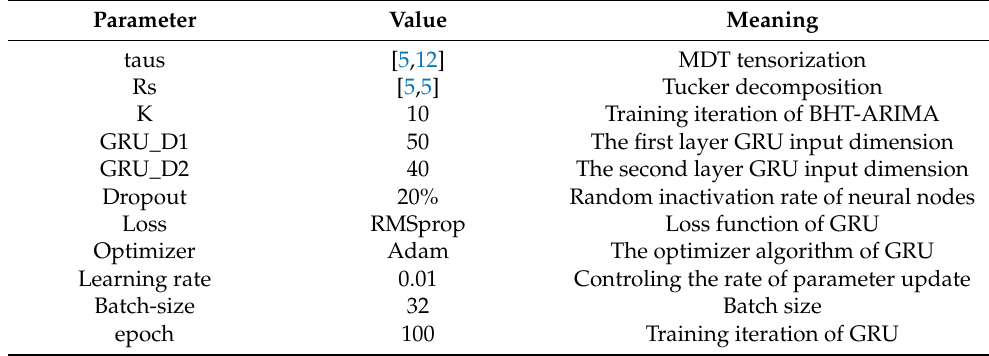
Table 3. The optimal hyperparameters.